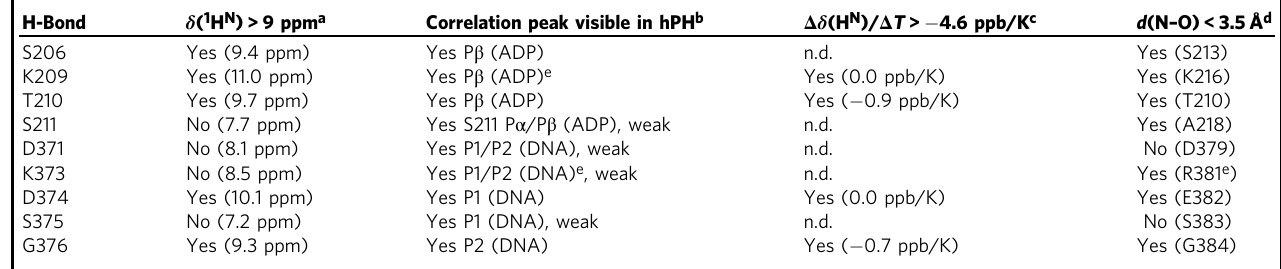
Table 1 Summary of spectroscopically identi fi ed hydrogen bonds.